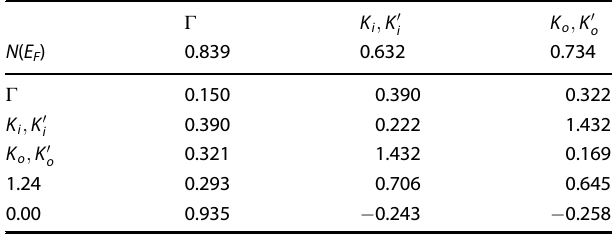
Table 3. Calculated electron – phonon coupling matrix V ij in